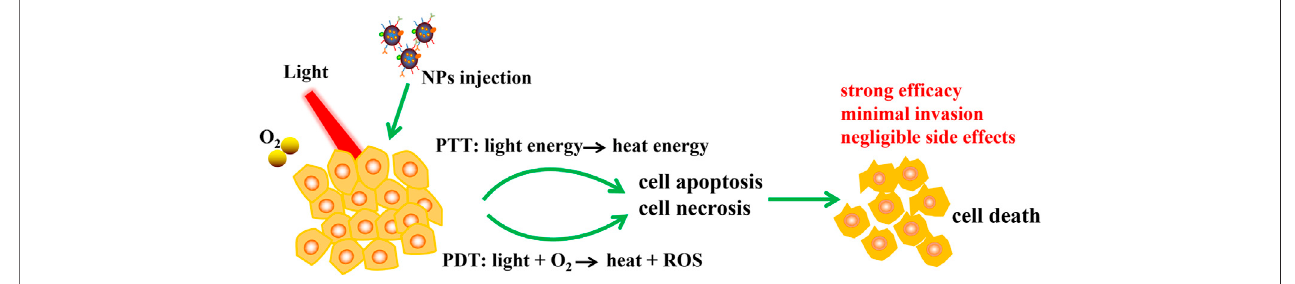
FIGURE 2 | Schematic illustration of NPs based PTT and PDT therapy. NPs was injected to tumor, PTT and PDT convert light energy into heat energy and induce ROSwiththehelpofexcitationlightandoxygen,thencellapoptosisandnecrosiswereoccurredand fi nallyleadingtocelldeath.PTTandPDThaveadvantagesincluding strong ef fi cacy, minimal invasion and negligible side effects.